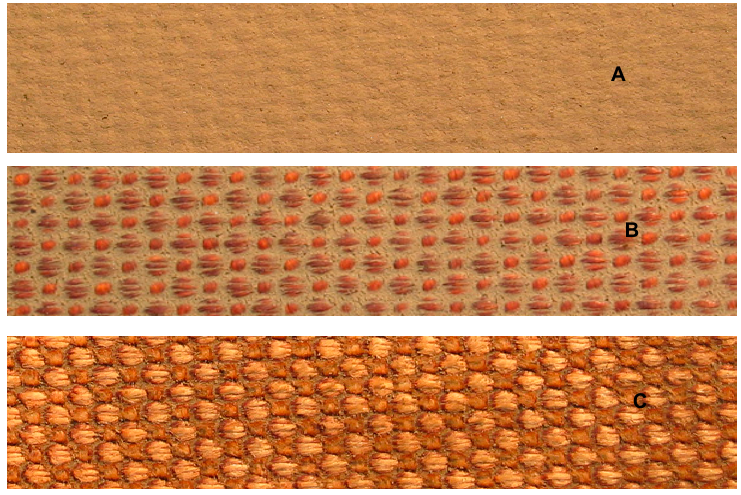
Figure 5. Textile plies: ( A )—unroughened, ( B )—roughened friction rubber, ( C )—roughened fabric.